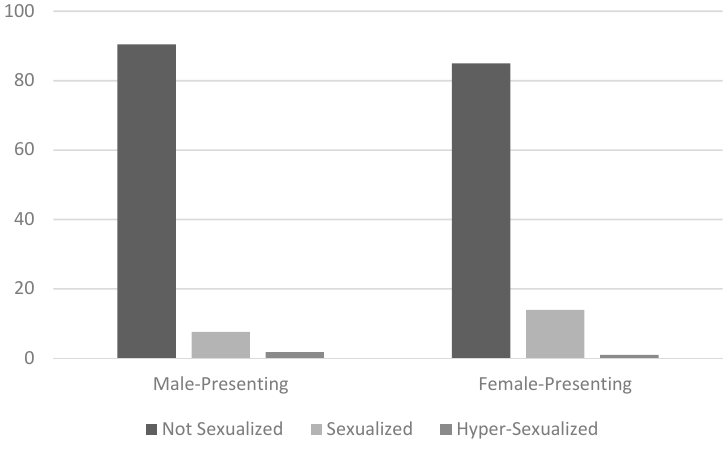
Figure 3. Distribution of Sexualization.